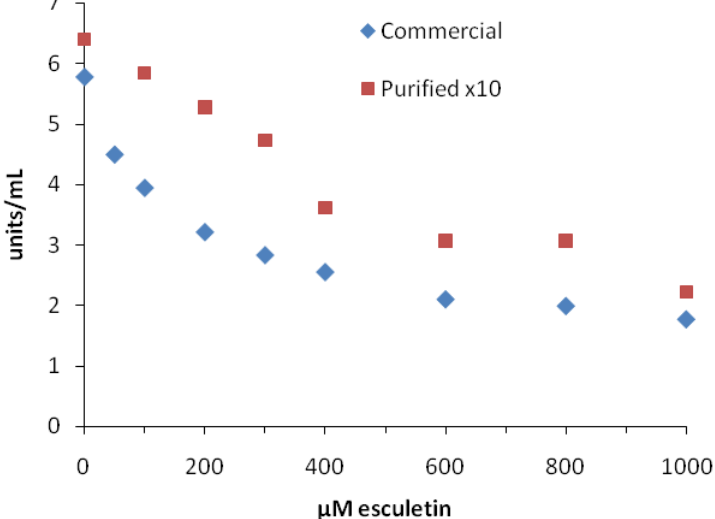
Figure 3. Inhibition of mushroom tyrosinase by esculetin. Assays were carried out as described in the Experimental